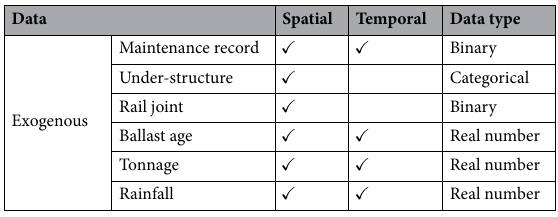
Table 3. Exogenous data.